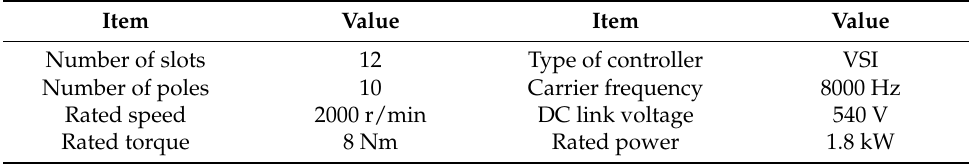
Table 1. Parameters of the prototype